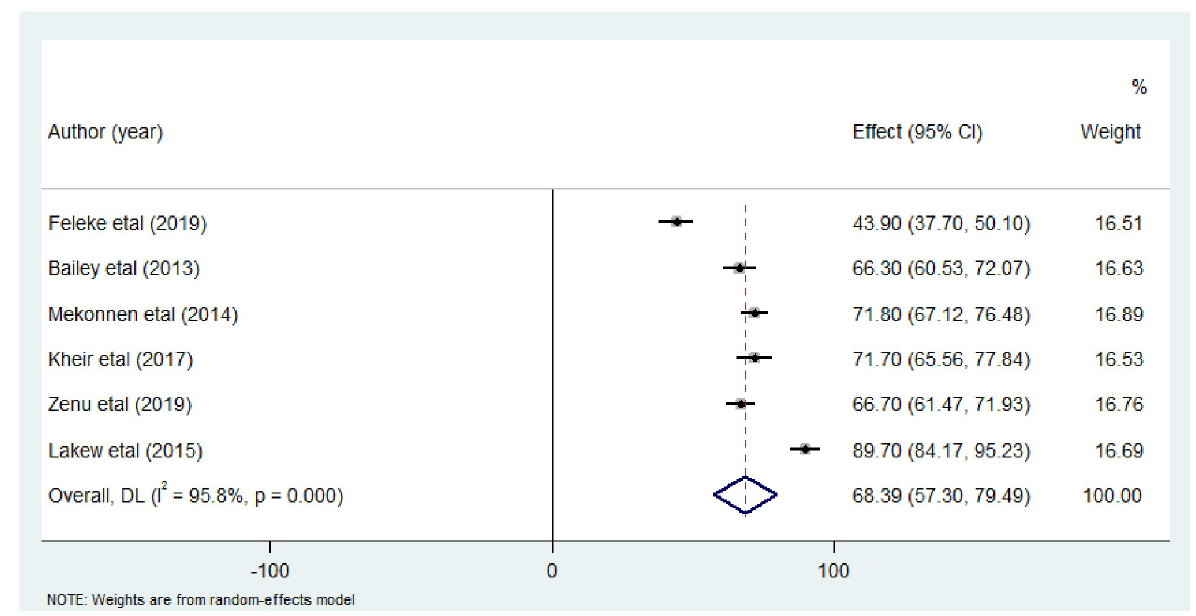
Fig 4. Forest plot showing the pooled prevalence estimate of intestinal parasitic infection among street dwellers.